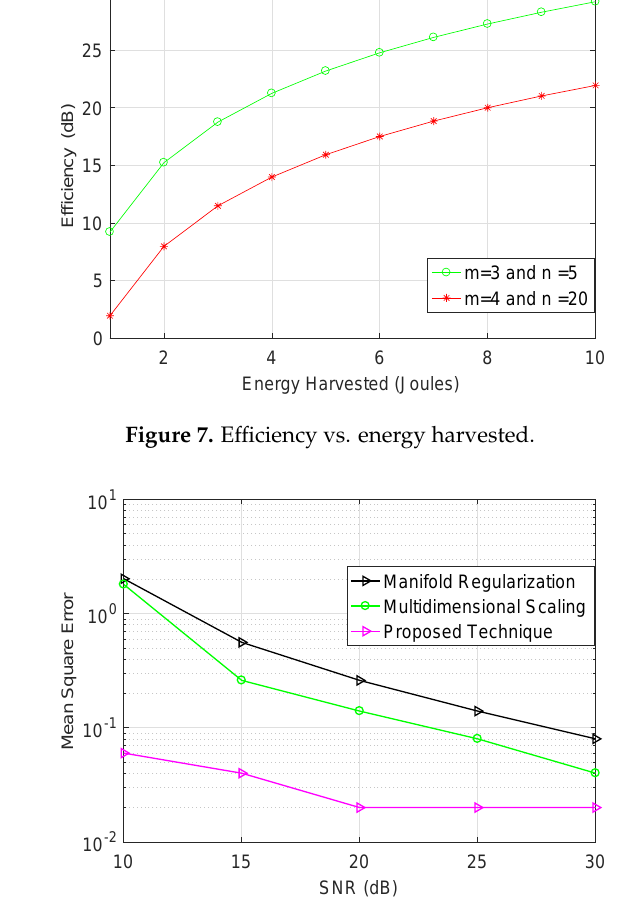
Figure 8. Signal to noise ratio (SNR) vs. mean square